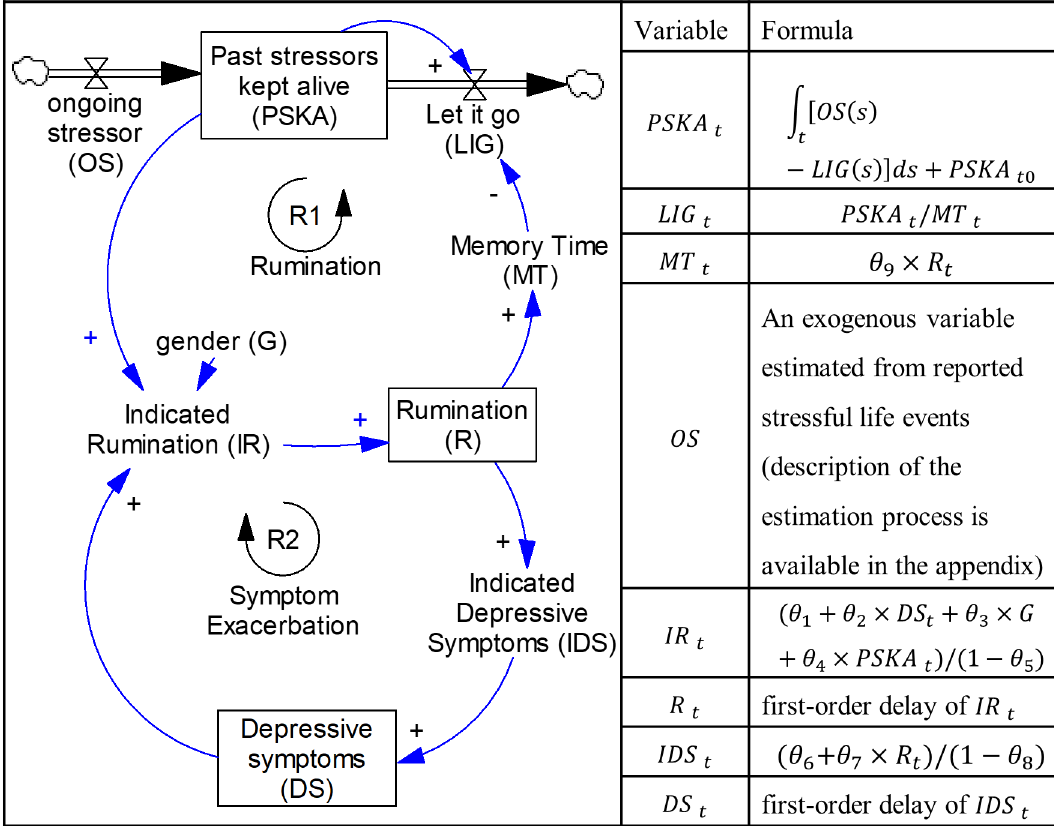
Fig 1. The depression-rumination conceptual model. Boxed variables represent stocks (or states), and double arrows with valves depict flows into/out of the stocks. Single-line arrows present hypothesized causal relationships—their strength is estimated below. A stock variable, which is mathematically represented as an integral, is the accumulation of the difference between its inflows and outflows.